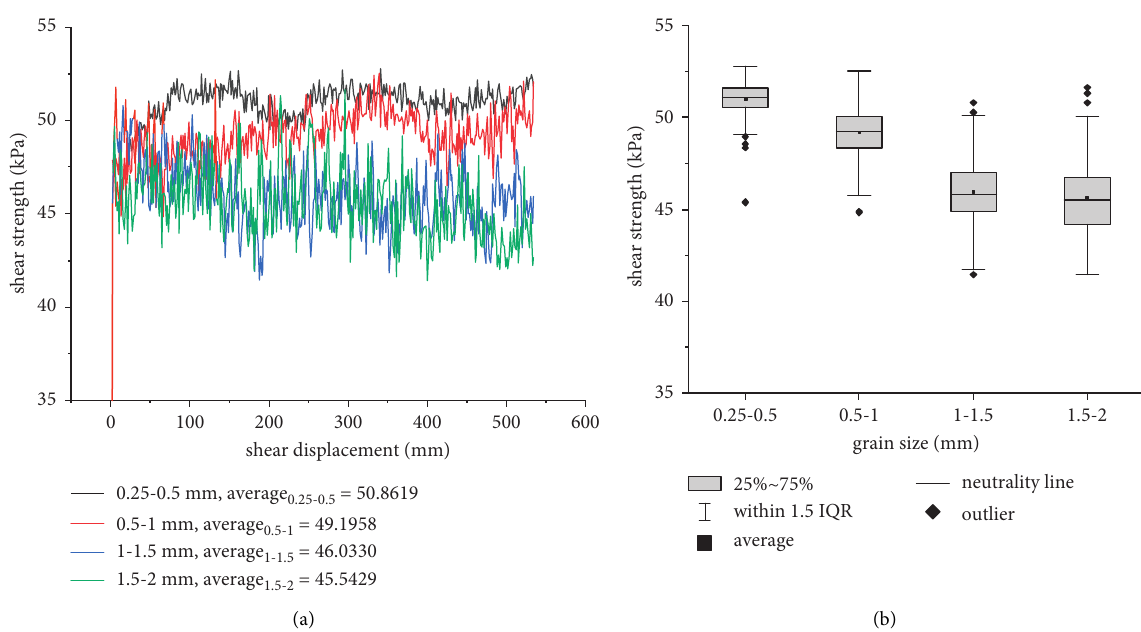
Figure 2: Distribution of shear strength in different grain sizes. (a) Shear stress-displacement curves of particles with different grain sizes. (b) Box plot of shear strength for different grain sizes.